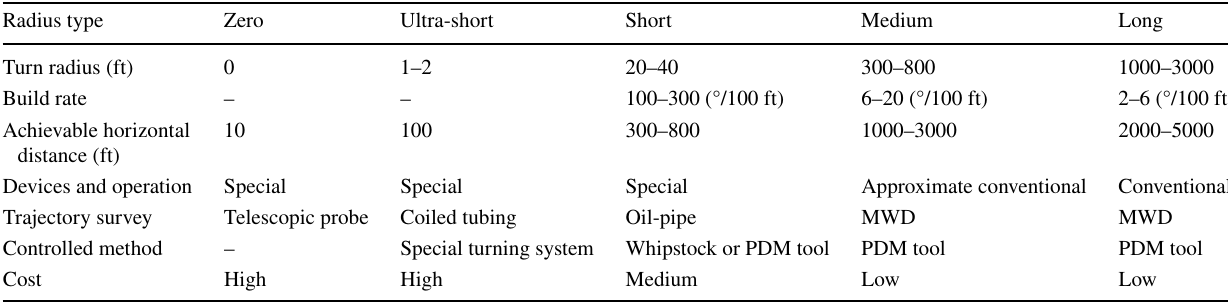
Fig. 4 Schematic of CBM horizontal well with different turn radius, modified from Flores (2013) Table 1 Classification of the horizontal well, after Flores (2013) and Ma et al.